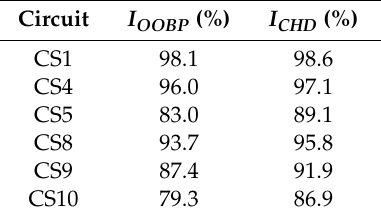
Table 11. Optimized pumping operation and supplied hydraulic head indicator for variable water demand circuits.